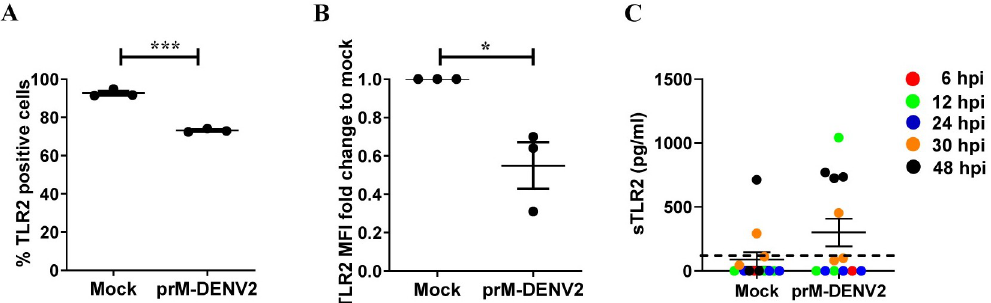
Fig 6. prM-DENV2 downregulates TLR2 surface expression on monocytes within the PBMCs. PBMCs from healthy donors (n = 3, three different donors) were exposed to prM-DENV2 at MOG 300 for 6h, 12h, 24h, 30h and 48h. ( A ) Percentages of TLR2 positive monocytes were determined by flow cytometry. ( B ) Fold changes in surface expression of TLR2 relative to the mock. ( C ) Concentration of sTLR2 in the supernatants exposed to prM-DENV2 determined by ELISA. Error bars represent mean ± SEM. P values were obtained by one-tailed t test. ( � P < 0.05; ��� P < 0.001).